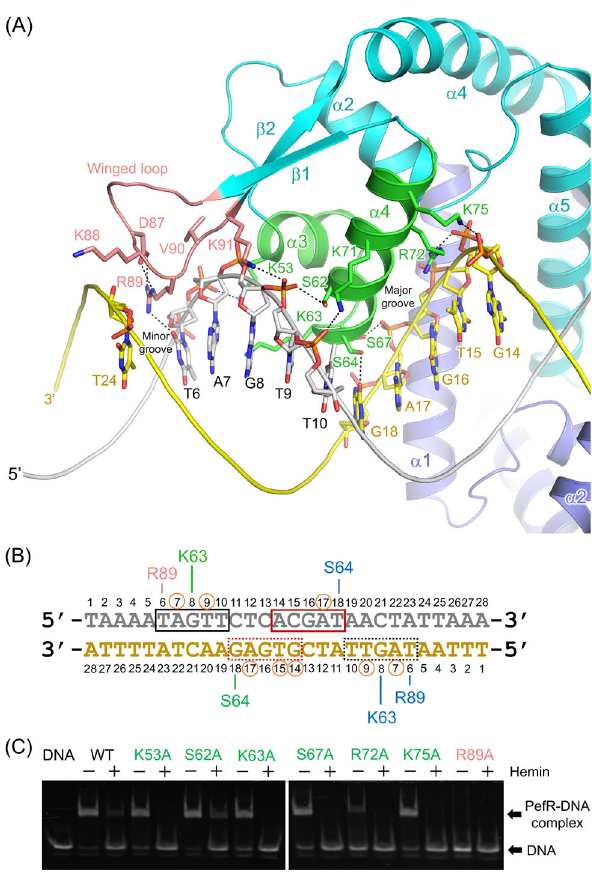
Fig. 3 Interactions with the target DNA. A Close-up view of the wHTH region (pink and green) and the target DNA. Hydrogen-bonding interactions are represented by dotted lines. B DNA sequence of the target DNA in the crystal structure. Gray- and yellow-colored letters with numbers, as well as A , show the bases and their sequence number in the chains of the target DNA. The black- and red-colored rectangles enclose the corresponding bases for DNA recognition by the other subunit of the PefR dimer. Amino acids with bars indicate interactions with bases, which are shown in the same color in A . Orange circles show positions of interactions between phosphate backbones and the side chains of amino acids. C EMSA of wild type and variants in the HTH region (green) and the wing loop (pink) of PefR. DNA (5 μ M), hemin (10 μ M) and wild-type or variant apo-PefR protein (5 μ M in the dimer) were mixed for electrophoresis. Hemin addition is shown as − (without) and + (with). The target DNA was 28bp long and contained the operator sequence for the pefRCD operon, which is the same sequence as used for obtaining the crystal